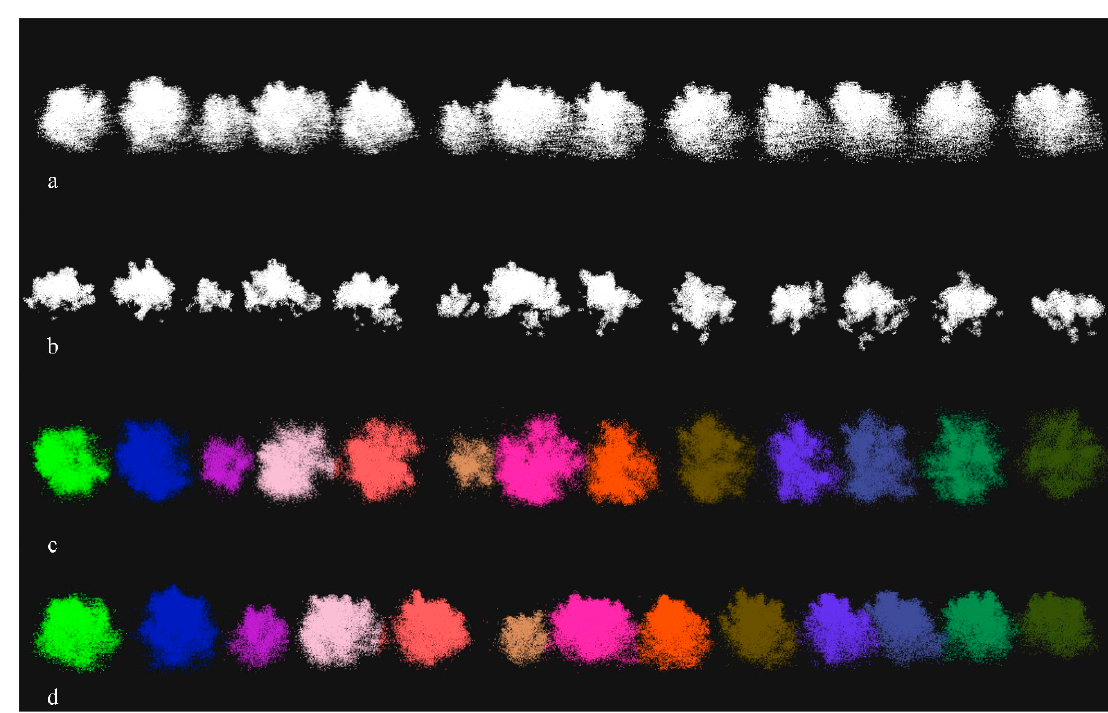
Figure 5. Fruit tree point cloud segmentation process: ( a ) the original point cloud, ( b ) the point cloud after Statistical Outlier Removal (SOR) filtering, ( c ) the point cloud after Euclidean clustering, and ( d ) the point cloud to restore point cloud information through a k-nearest neighbour (KNN) search algorithm.